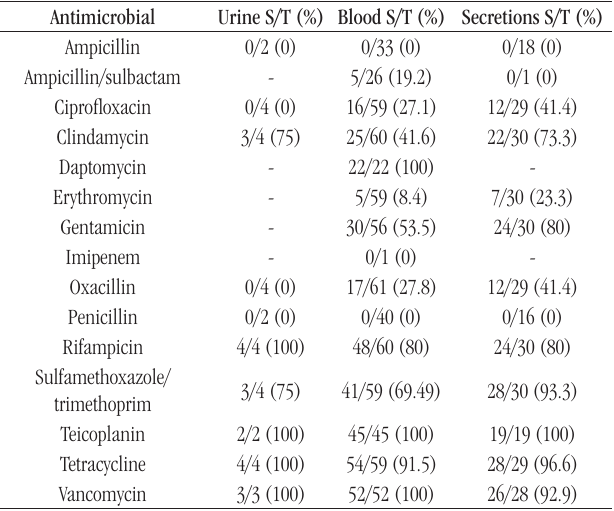
taBLE 6 − Susceptibility profile of Staphylococcus aureus isolated from different clinical specimens in antimicrobial testing Antimicrobial Urine S/T (%) Blood S/T (%) Secretions S/T